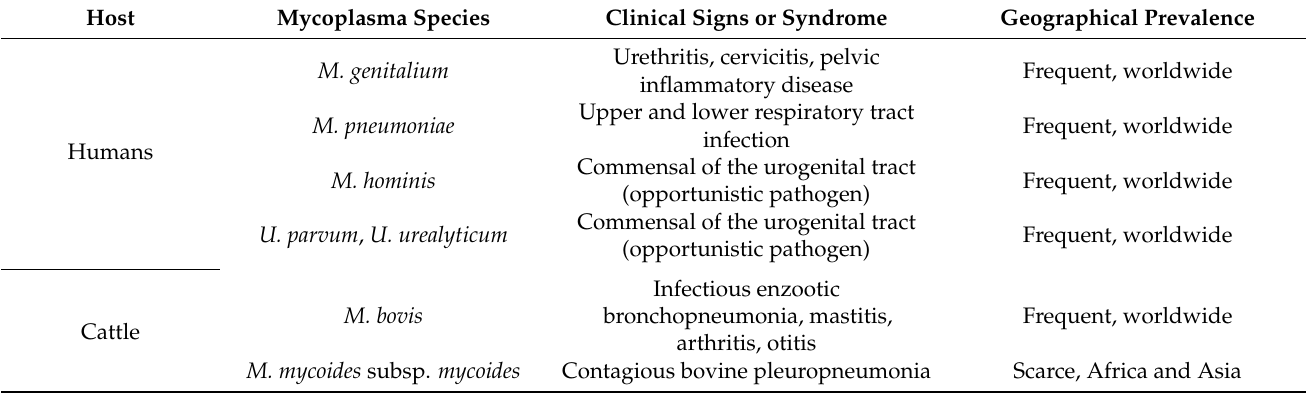
Table 1. List of clinically relevant species in human and animals, including the associated clinical signs and their preva- lence